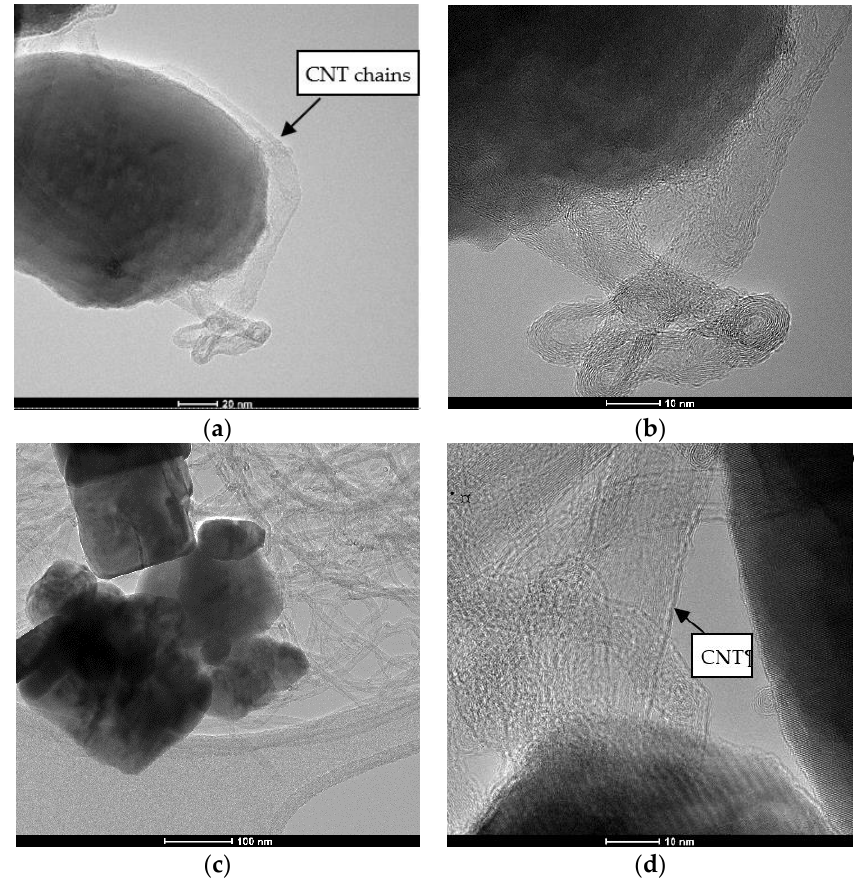
Figure 9. TEM images of CNT-ZnO-3 (weight ratio CNT:ZnO = 1:5) and CNT-ZnO-4 (weight ratio CNT:ZnO = 1:4) nanocomposite powders: ( a ) CNT-ZnO-3 sample. Polyhedreral rod-like shaped ZnO nanoparticles covered with CNT (scale 20 nm); ( b ) HR-TEM image of CNT-ZnO-3 nanocomposite powder at 10 nm; ( c ) CNT-ZnO-4 sample. Polyhedreral rod-like shaped ZnO nanoparticles covered with CNT (scale 100 nm); ( d ) HR-TEM image of CNT-ZnO-4 nanocomposite powder at 10